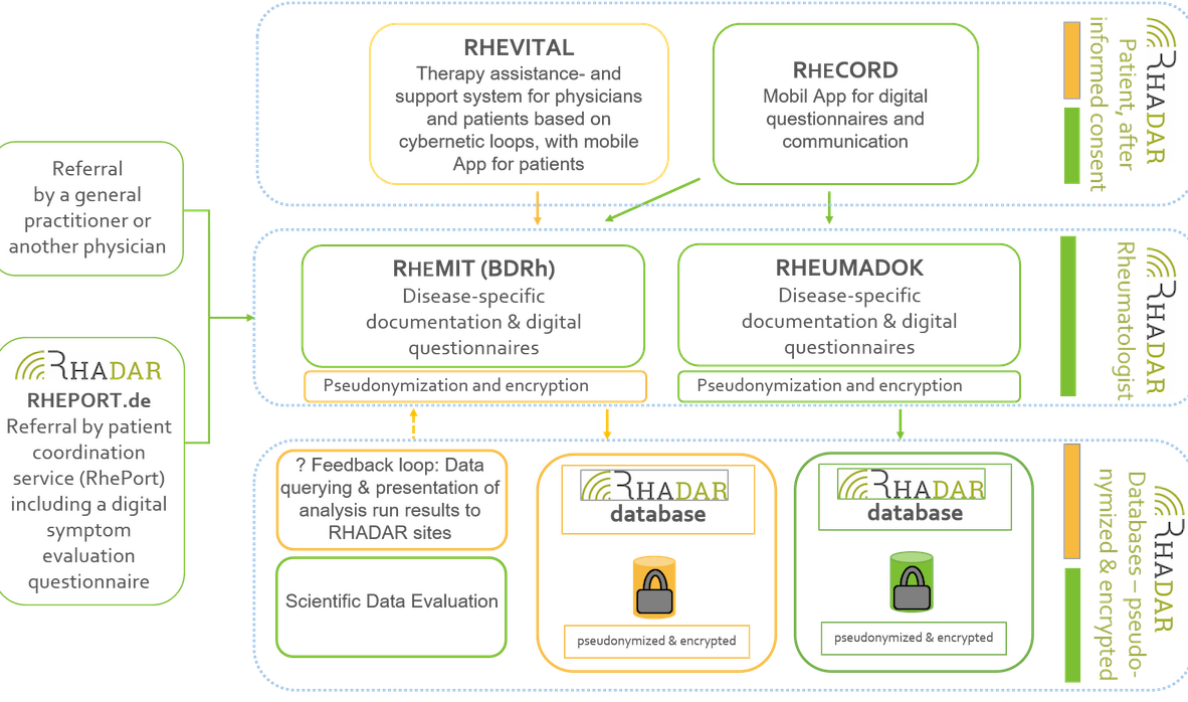
Figure 1. RHADAR patient and data pathway. Green boxes resemble established parts of the RHADAR network. Orange boxes are in preparation. RHADAR: RheumaDatenRhePort.